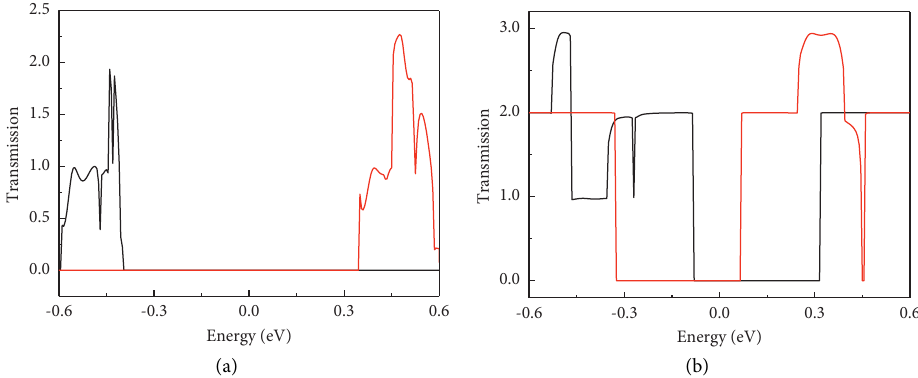
Figure 6: Spin-related transmission spectrums of the N-ZKGNRs devices: (a) N � 4; (b) N � 21, in which spin-up and spin-down transmissions are described by the solid black and red lines.